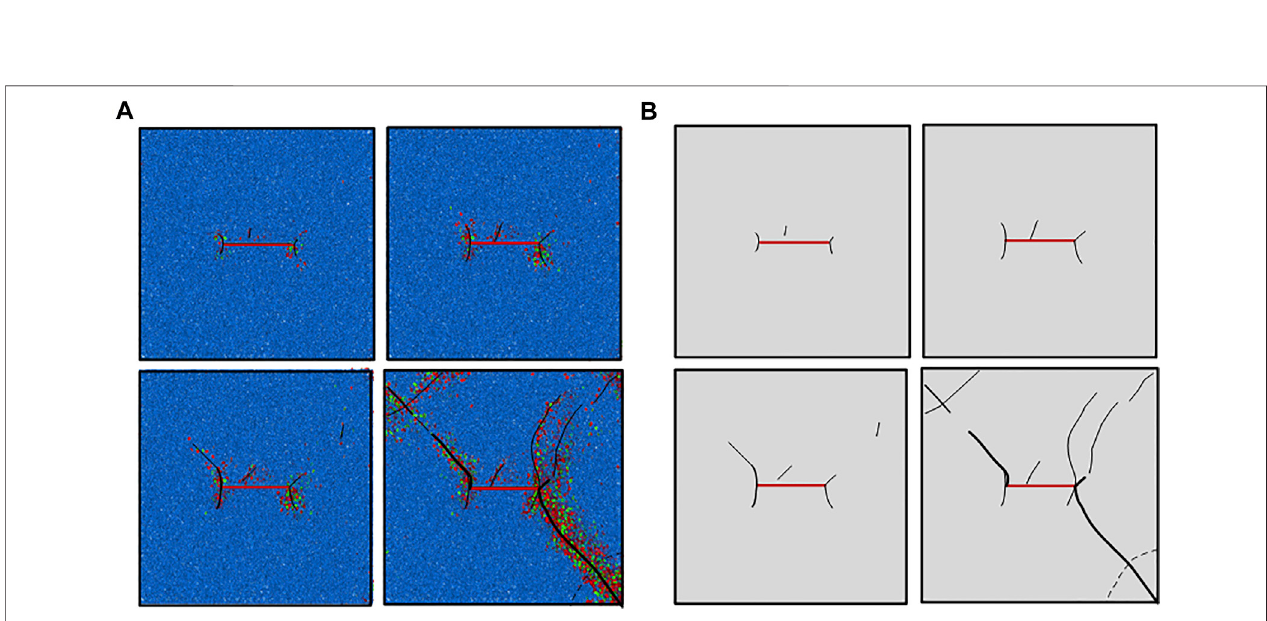
FIGURE 8 | Sample simulation and sketch under loading plan B. (A) Simulation diagram of loading plan B; (B) sketch of the fracture.